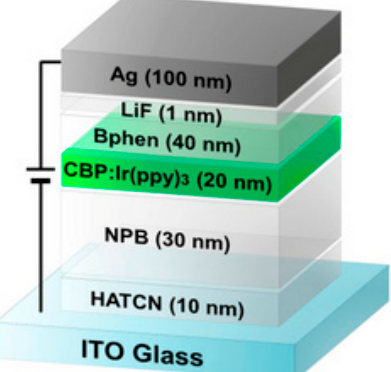
Figure 18. Example of a cross section of a polymer LED. Modified from [152] MDPI 2014 (CC by